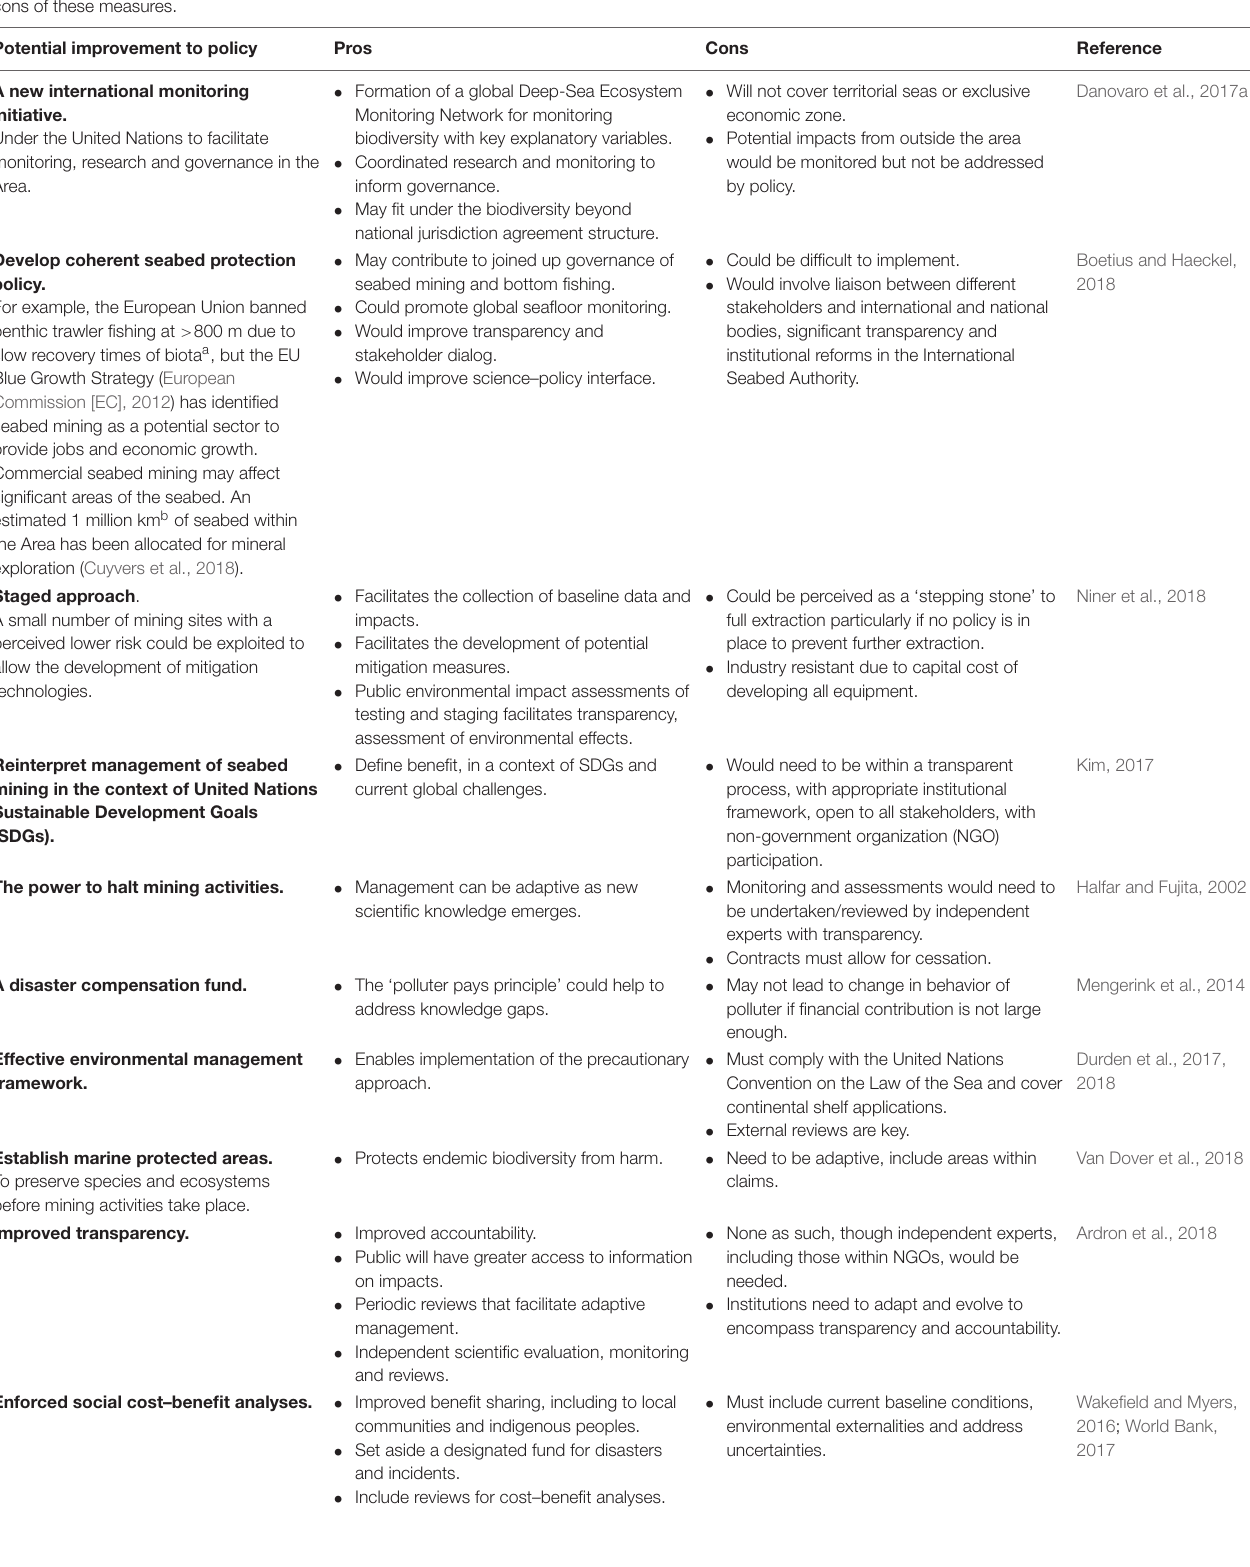
TABLE 1 | An overview of literature that discusses seabed mining policy, management, enforcement and alternatives and our evaluation, which sets out the pros and cons of these